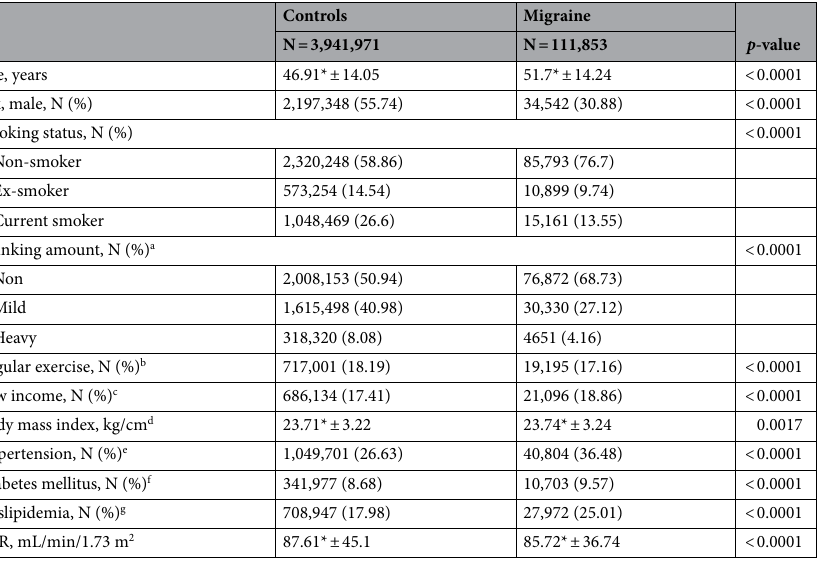
Table 1. Baseline characteristics of patients with migraines and controls. N numbers, GFR glomerular filtration rate. a Drinking amount: Individuals who consumed more than 30 g of alcohol per day were defined as heavy drinkers. b Regular exercise: Regular physical activity was defined as doing high-intensity exercise for at least 20 min three times per week or at least 30 min of moderate-intensity exercise five times per week. c Low income: The low-income level was defined as the bottom 20% of the total population. d Body mass index (BMI): BMI was calculated as weight (kg) divided by height (m) squared. e Hypertension (HTN): Hypertension was defined as a prescription at least once per year for antihypertensive drugs under ICD-10-CM codes I10–I13, I15, or blood pressure (BP) of ≥ 140/90 mmHg. f Diabetes mellitus (DM): DM was defined as fasting glucose of ≥ 126 mg/dL or at least one prescription per year for one or more antidiabetic drugs. g Dyslipidemia: